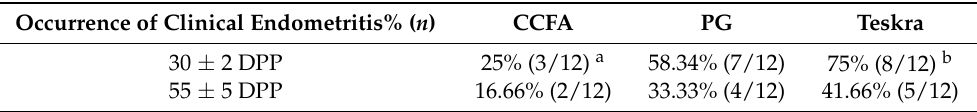
Table 2. Effect of treatment protocol on the occurrence of clinical endometritis at 30 ± 2